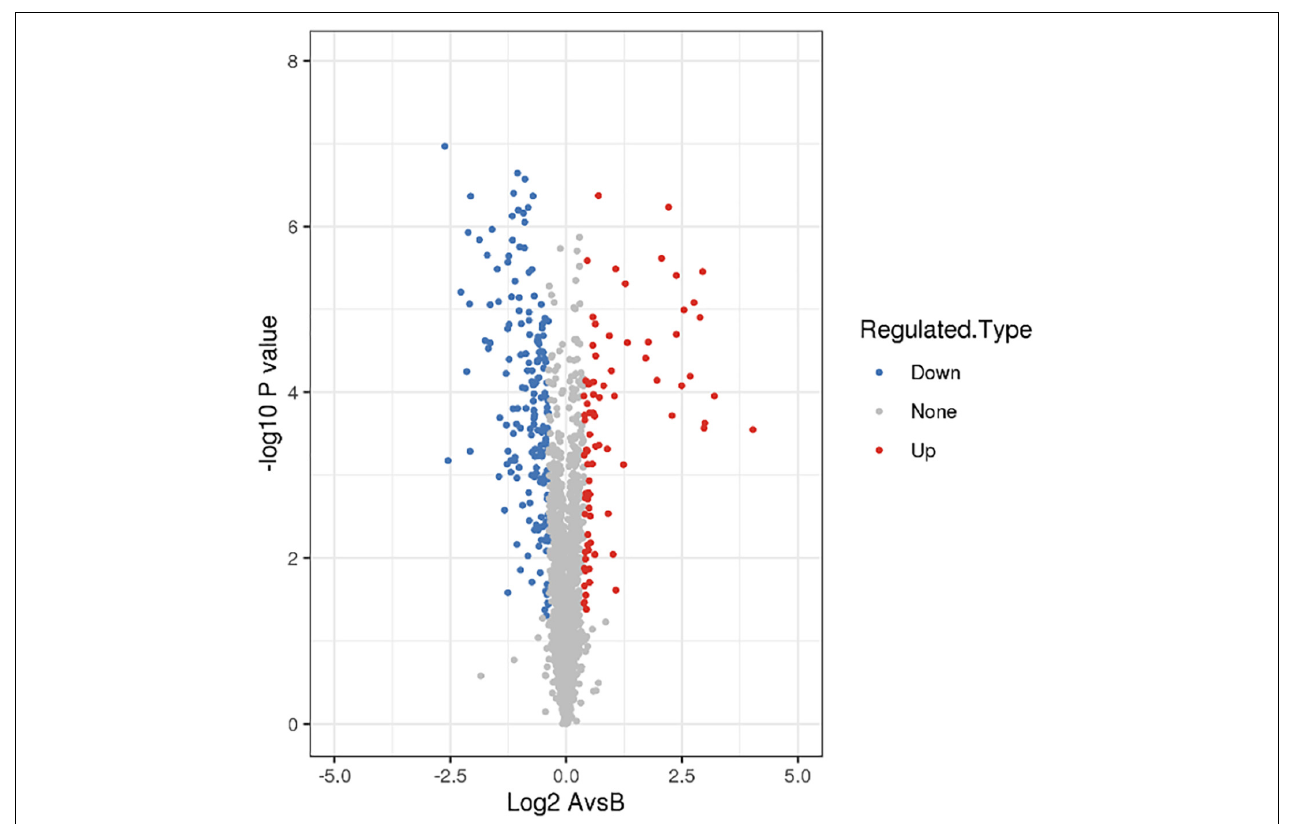
FIGURE 1 | Screening of differentially expressed